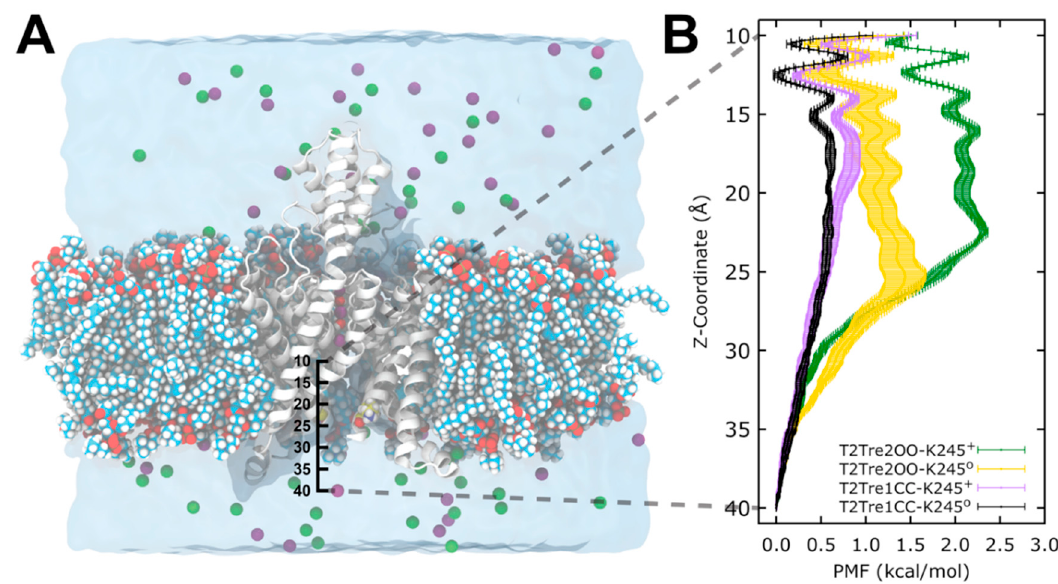
Figure 7. Potential of mean force (PMF) of K245 in TASK-2 channel. The PMF calculations were measured as is depicted in ( A ), translocating one K + ion from the cytosolic region (coordinate Z = 40 Å) to the central cavity (coordinate Z = 10 Å) below to the selectivity filter in the Z -axis for the four configurations; ( B ) The free energy barriers calculated along the conduction pore in the Z -axis [10, 40] Å.